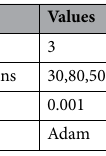
Table 1. Values of the parameters of the RNN